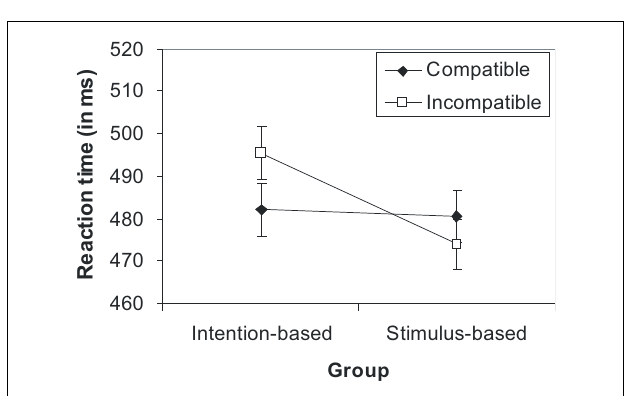
FIGURE 4 | Stimulus (S1–S2) repetition benefits (RT alternation -RT repetition ) in Experiment 3 for stimulus features number and gender for intention-based (left panel) and stimulus-based group (right panel) as a function of response